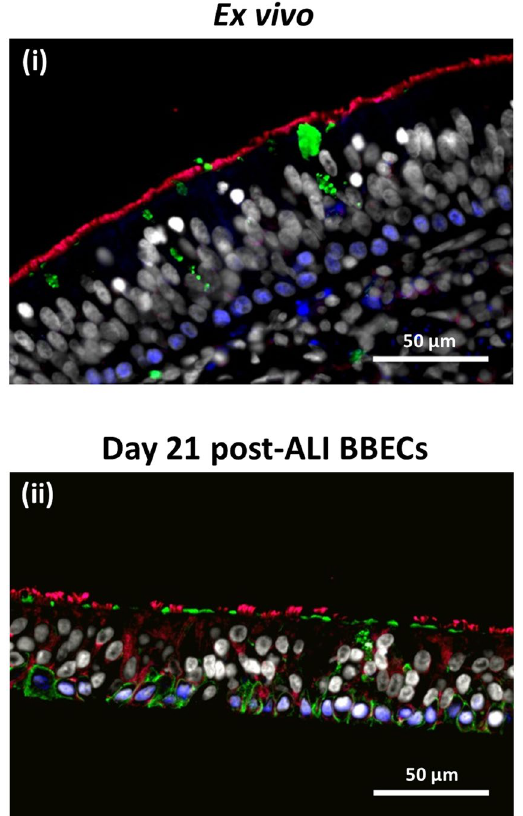
Figure 2. Comparison of cellular composition, morphology and polarisation of differentiated BBECs and ex vivo bronchial epithelium using fluorescent immunohistochemistry. Ex vivo bronchial epithelium dissected from the donor animal before cell extraction (i) and day 21 post-ALI BBEC cultures (ii) were fixed and paraffin-embedded using standard histological techniques. Sections were cut, deparaffinised and immunohistochemically stained to identify markers of specific epithelial cell-type as follows: cilia (ciliated cells) - red; Muc5AC (mucus and goblet cells) - green; p63 (basal cells) - blue; nuclei -